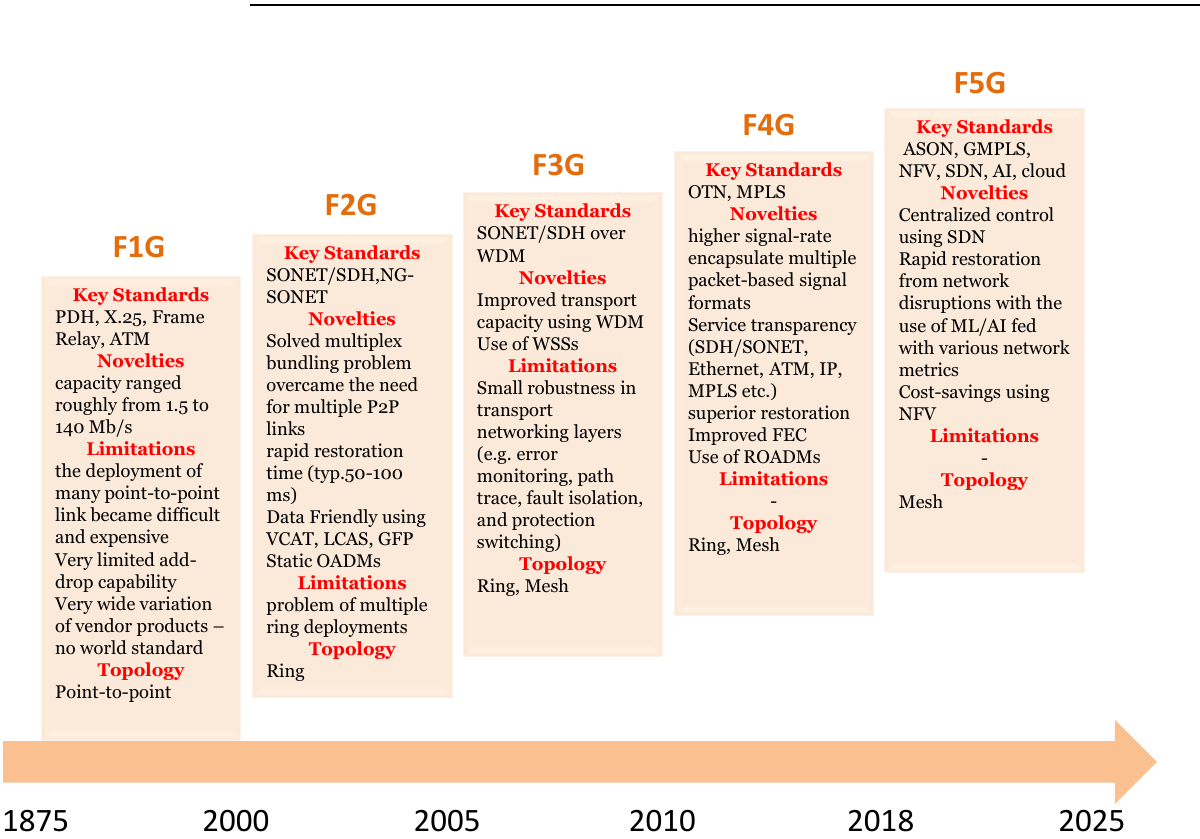
Figure 21. Timeline of five generations of backbone network standards.